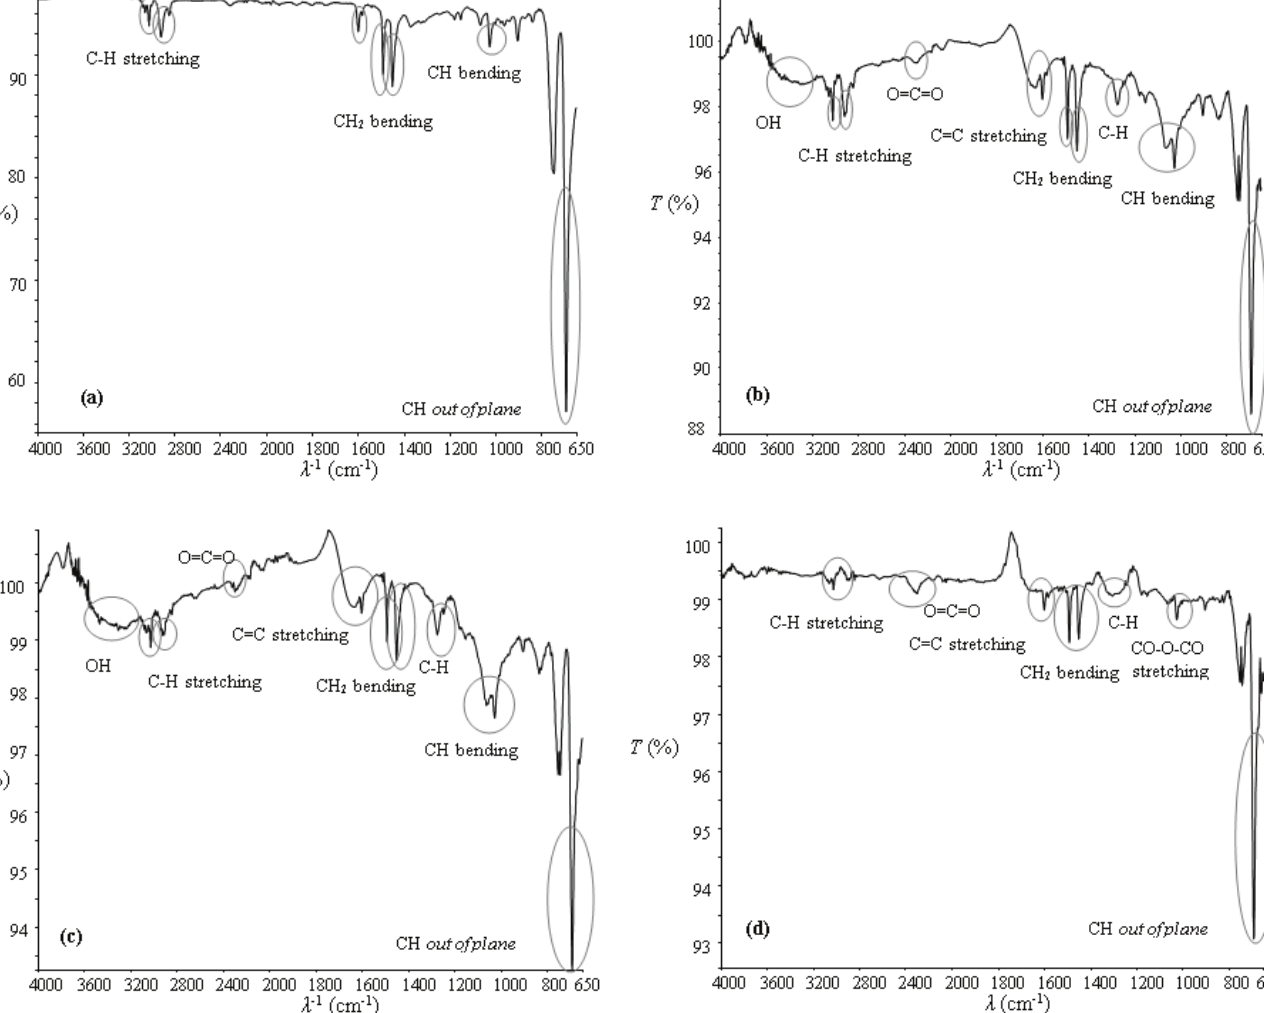
Fig. 11 – FTIR-ATR spectrum before (a) and after biodegradation of MP-PS with bacterial culture Bacillus licheniformis (b), Lysinibacillus massiliensis (c) and mixed bacterial culture of Bacillus sp. and Delftia acidovorans